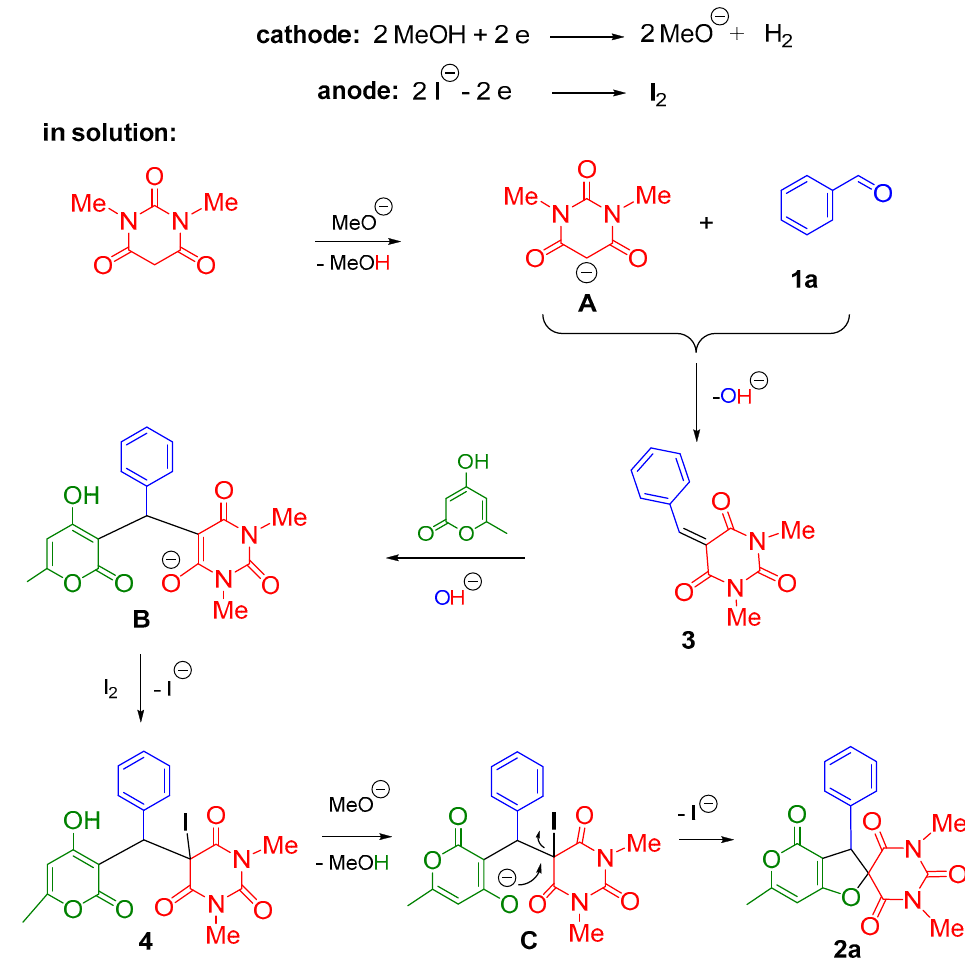
Scheme 3. The mechanism of electrocatalytic multicomponent one-pot synthesis of spiro[furo[3,2- c ]pyran-2,5 ′ -pyrimidine] 2a